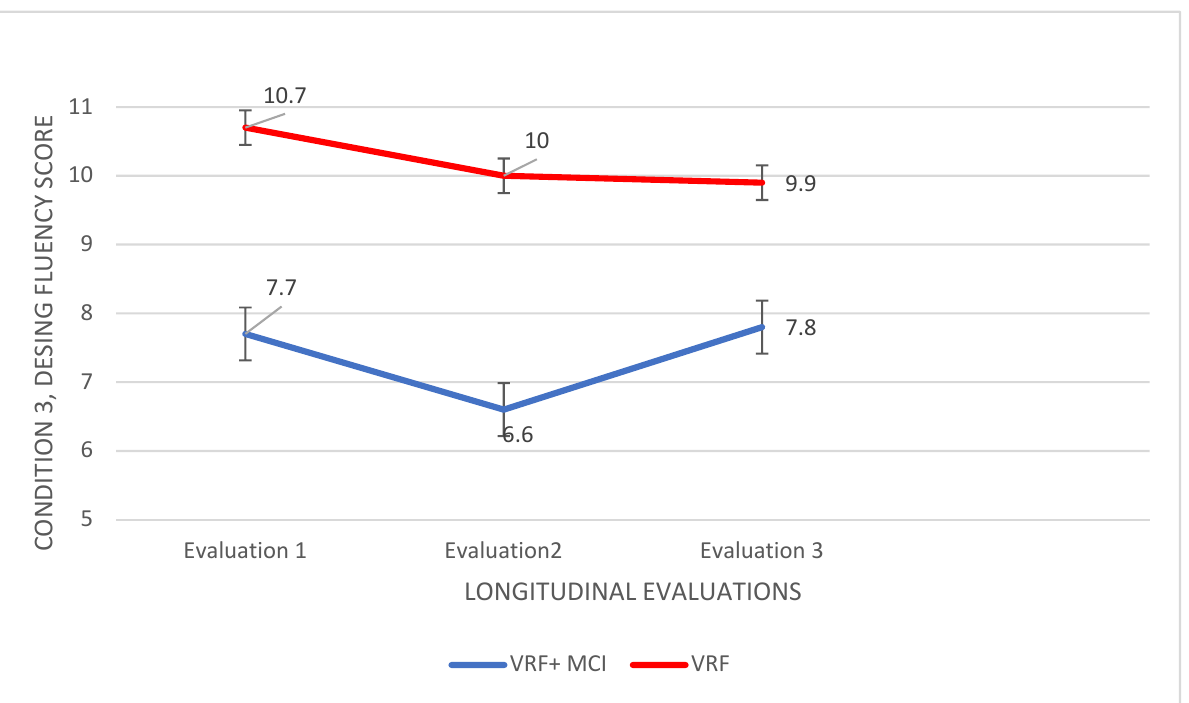
Figure 3. Performance of people with VRF and people with VRF + MCI in task/rule switching (Design Fluency: Condition C).